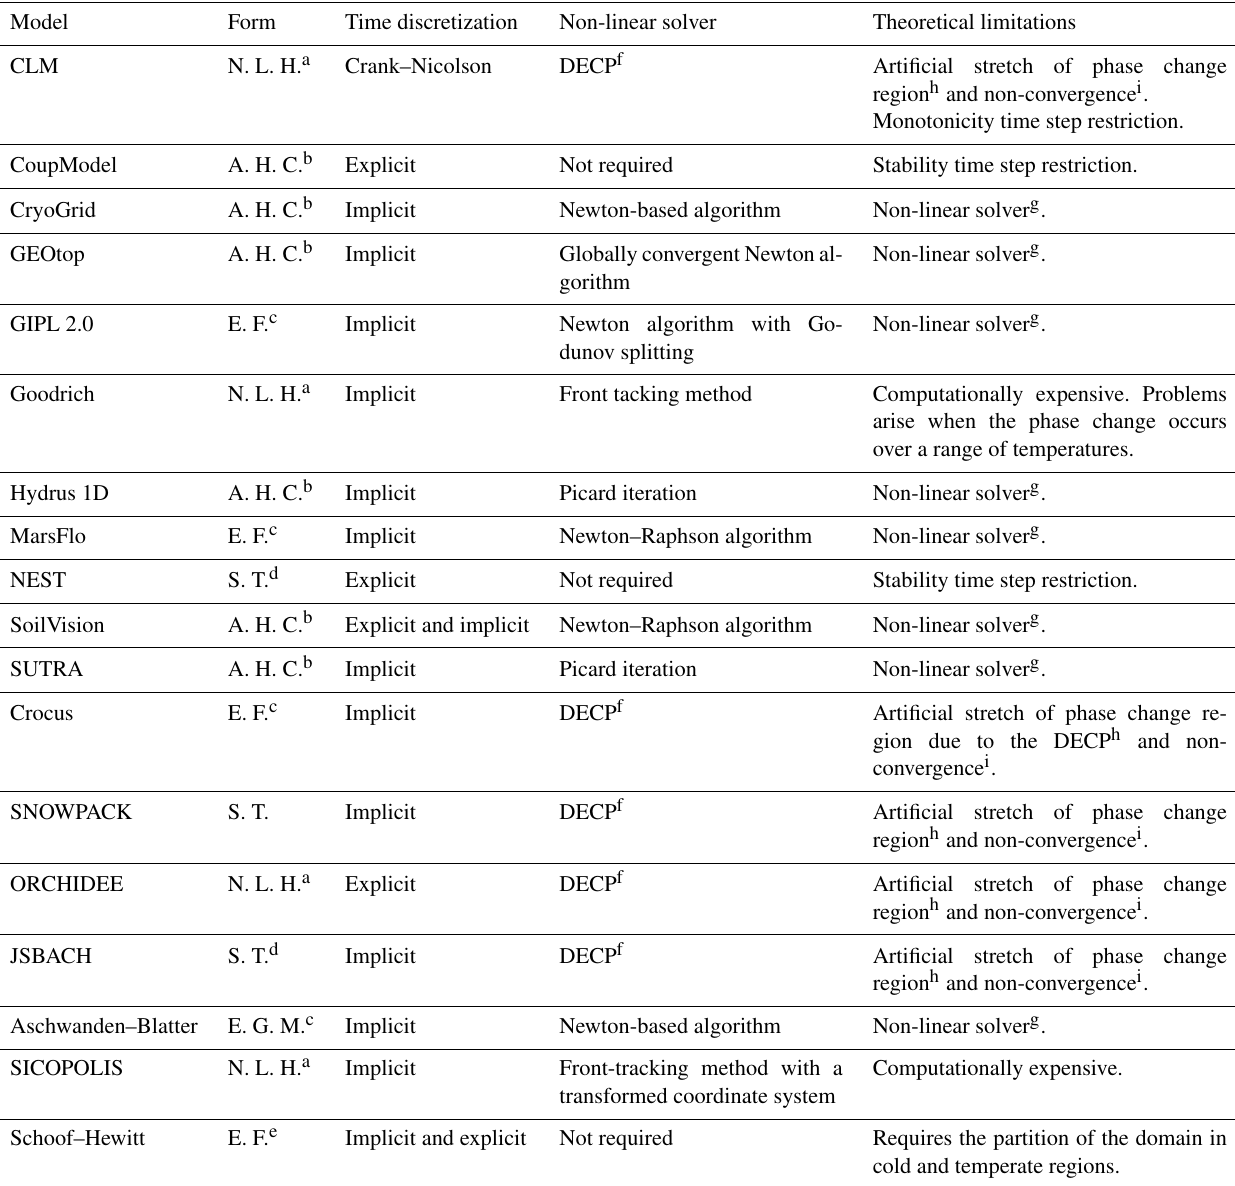
Table 1. Diversity of formulations and solvers in current models of heat transfer and phase change in the cryosphere. Theoretical limitations do not necessarily affect the usability of models for their intended purpose. More details are in Appendix